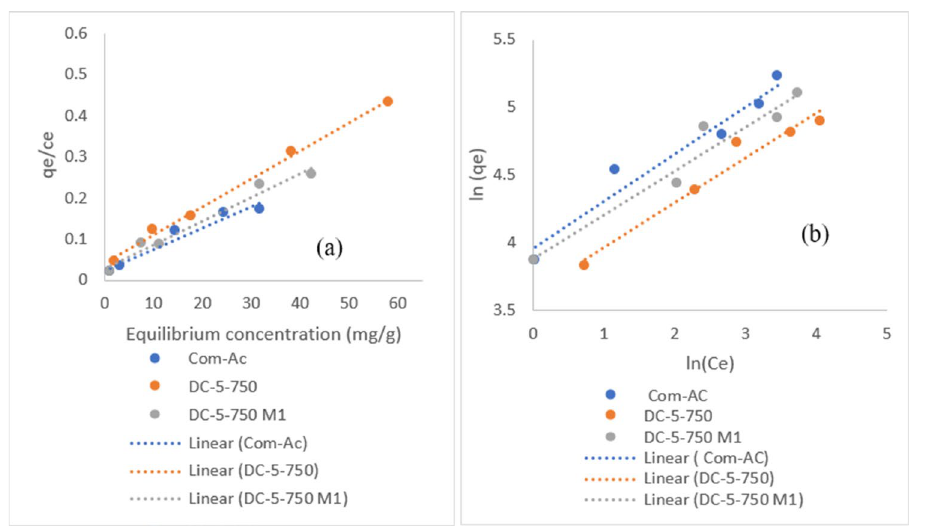
Figure 22. Langmuir ( a ) and Freundlich ( b ) isotherm plot of nitrate